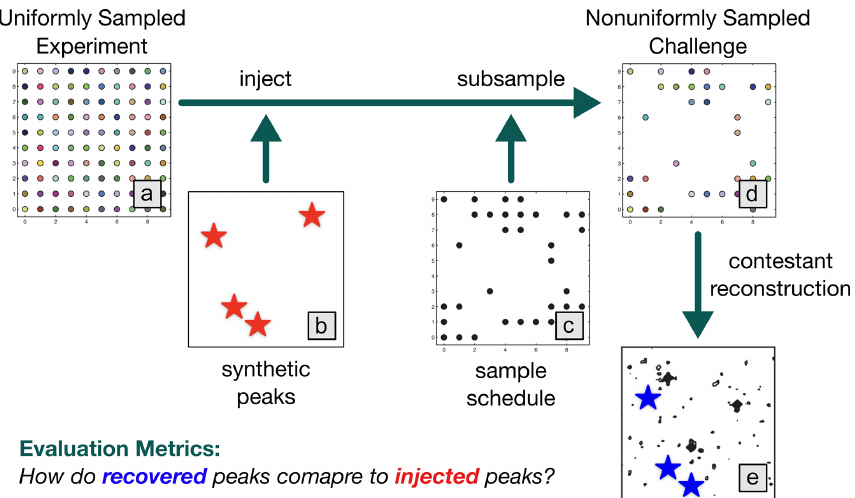
Figure 1. NUScon workflow. The uniformly sampled experiment (a) is injected with synthetic peaks ( b , red stars) and subsampled (c) to generate a nonuniformly sampled challenge data set (d) . Contestants provide scripts to reconstruct the spectra (e) . The recovered peaks ( e , blue stars) are compared against the injected peaks ( b , red stars) using a variety of metrics to determine spectral quality. Table 1. Descriptions provided to the contestants for each of the molecules used in the challenge